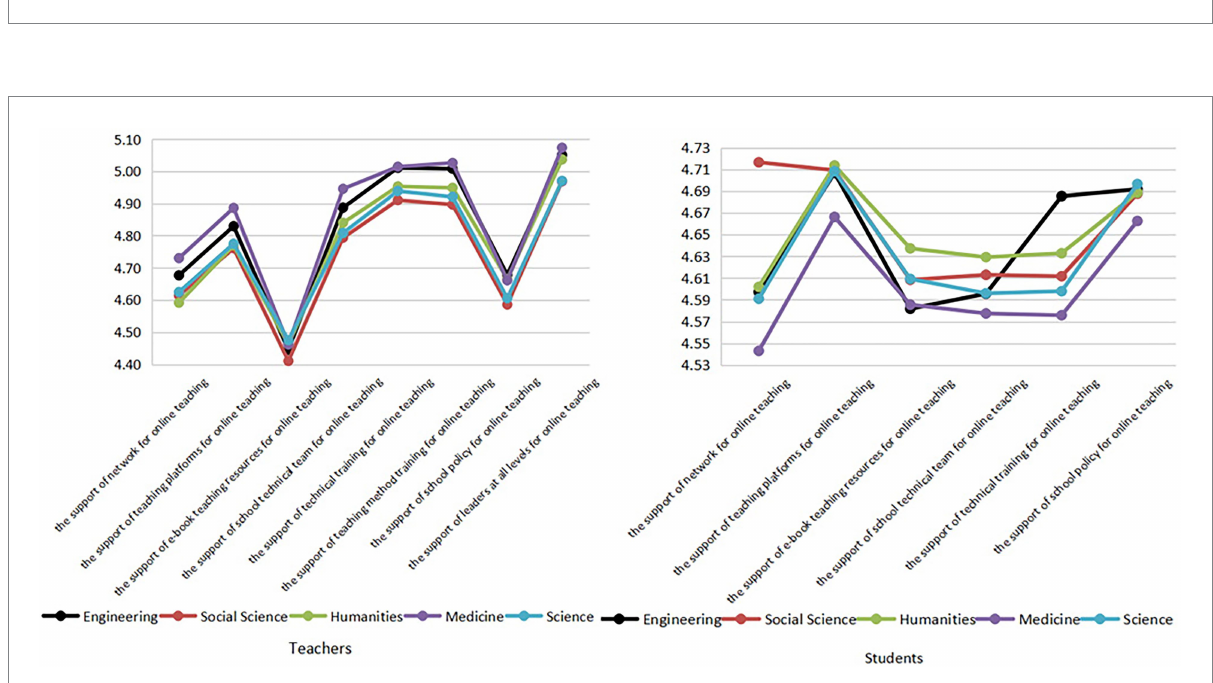
FIGURE 3 Evaluation of online service reliability by teachers and students of different disciplines.